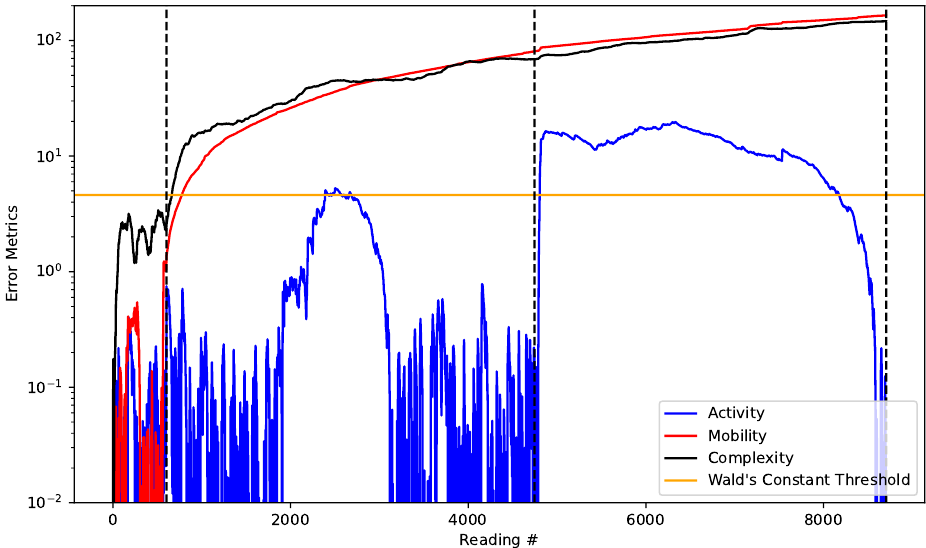
Figure 12. Evolution of all the error metrics of the Hjorth’s